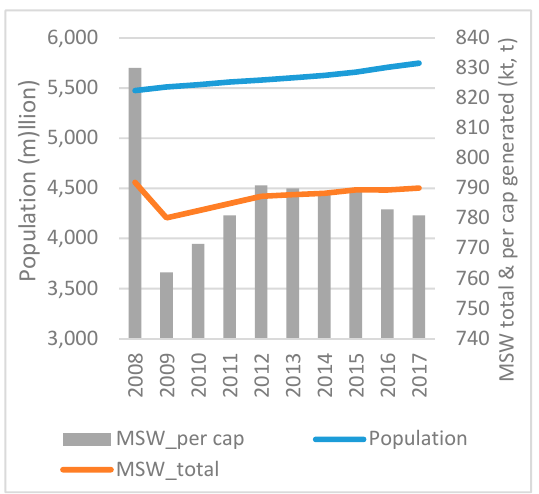
Figure 7. Population and MSW production in Denmark 2008–2017 (EUROSTAT 2019a, 2019c). Soc. Sci. 2019 , 8 , x FOR PEER REVIEW